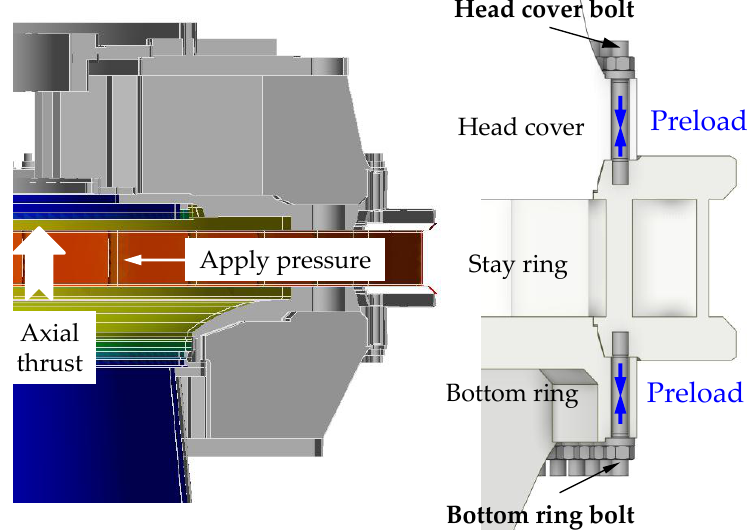
Figure 11. The applied loads and boundary conditions of the stationary structures of the PT unit.